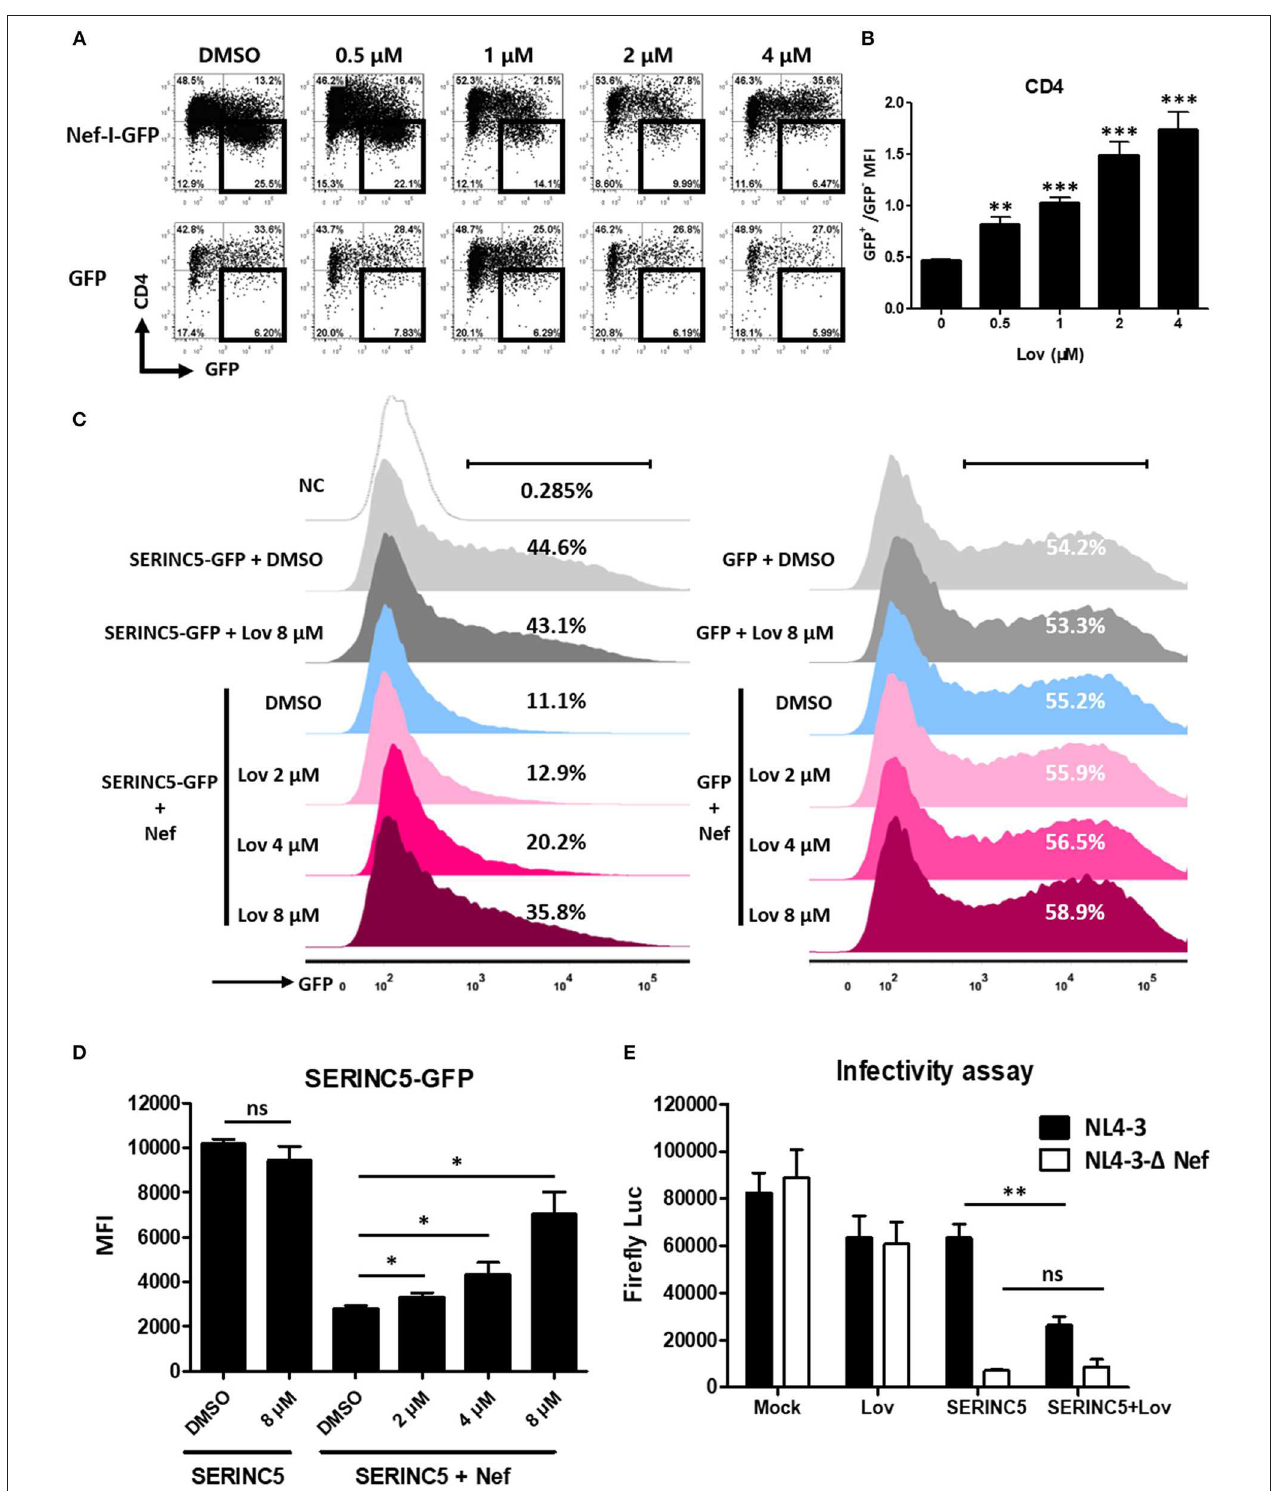
FIGURE 3 | Lovastatin inhibits the ability of Nef to down-regulate CD4 and SERINC5, and the intrinsic infectivity of virions. TZM-bl cells were transfected with pcDNA3.1-Nef-IRES-GFP or pcDNA3.1-IRES-GFP (800 ng per well). Twelve hours after transfection, the cultures were treated with lovastatin with the given concentrations. Forty-eight hours after transfection, the percentages of the GFP + CD4 − cells were analyzed by flow cytometry (A) . The ratios of CD4 MFI on GFP + to